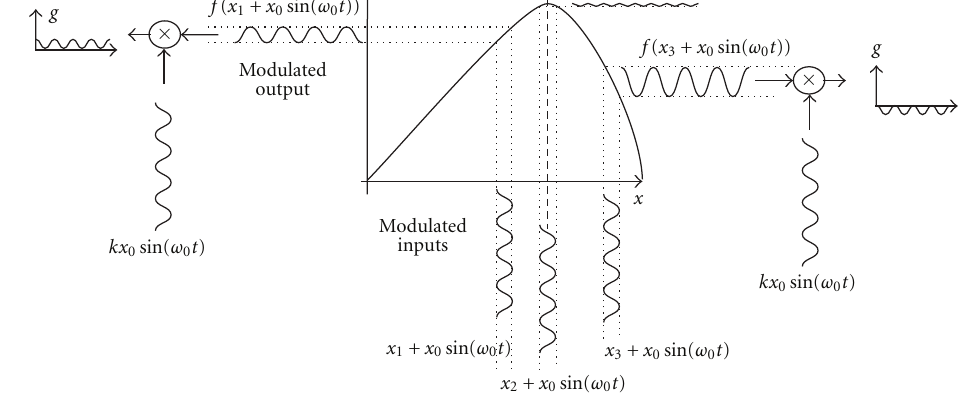
Figure 1: Sinusoidal ESC principle.